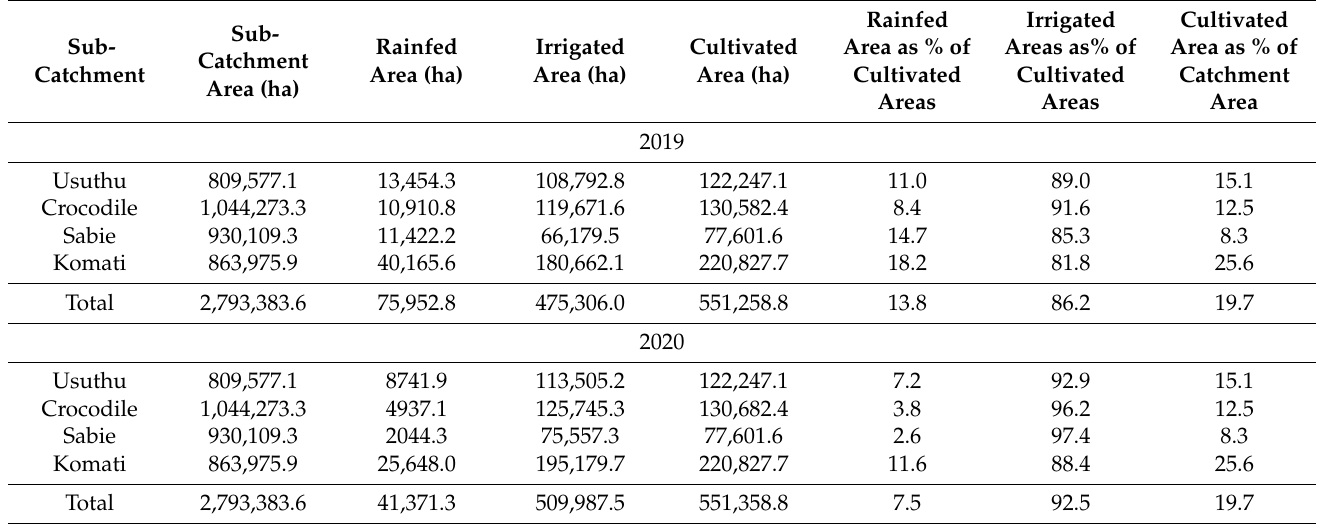
Table 2. Proportions of irrigated and rainfed areas per sub-catchment in 2019 and 2020.